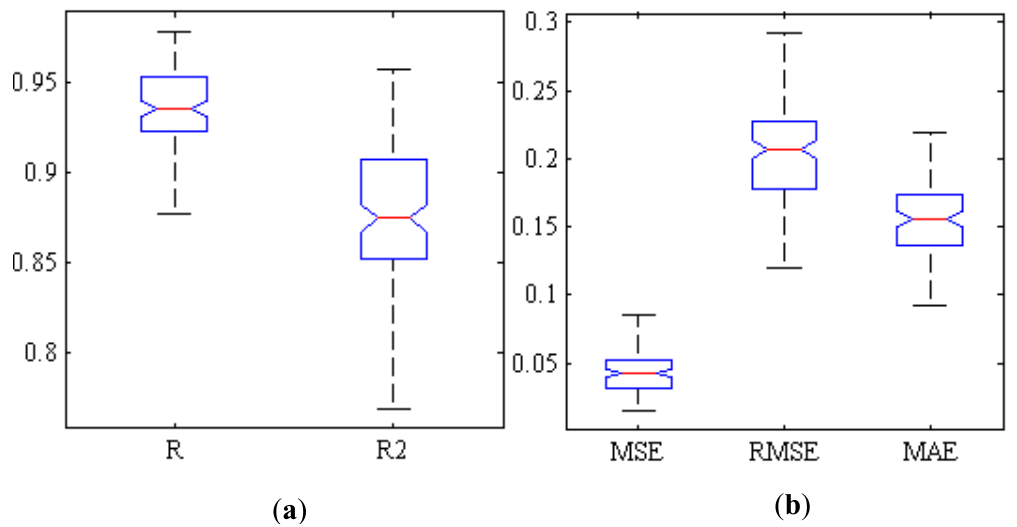
Figure 3. Regression analysis of the scatter plot between the mean estimated and the measured starch content in Fuji apple based on spectral data of 800 to 900 nm.